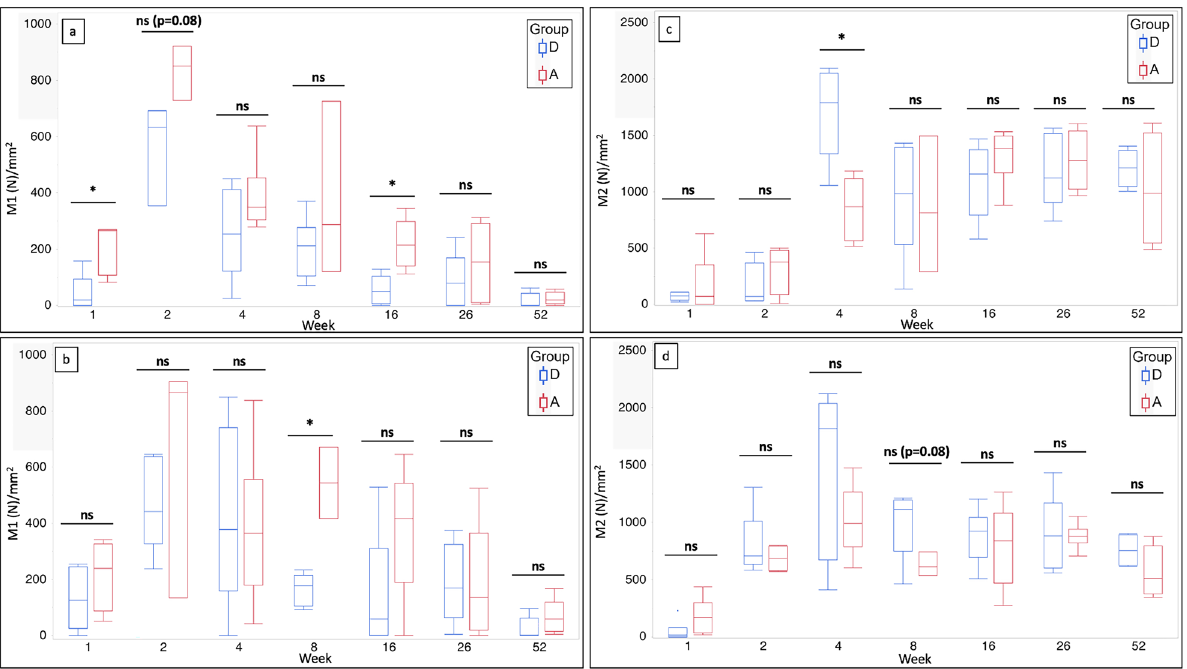
Figure 5. Comparison of the count of M1 and M2 macrophages that appeared in the decellularized and autologous tendons in rat anterior cruciate ligament reconstruction within up to 52 weeks after implantation. ( a ) Box plots showing the count of M1 macrophages in the intra-articular grafts of groups D and A at each time point (n = 6, for each period in each group). ( b ) Box plots showing the count of M1 macrophages in the intratibial tunnel grafts of groups D and A at each time point (n = 6, for each period in each group). ( c ) Box plots showing the count of M2 macrophages in the intra-articular grafts of groups D and A at each time point (n = 6, for each period in each group). ( d ) Box plots showing the count of M2 macrophages in the intratibial tunnel grafts of groups D and A at each time point (n = 6, for each period in each group). Group D decellularized